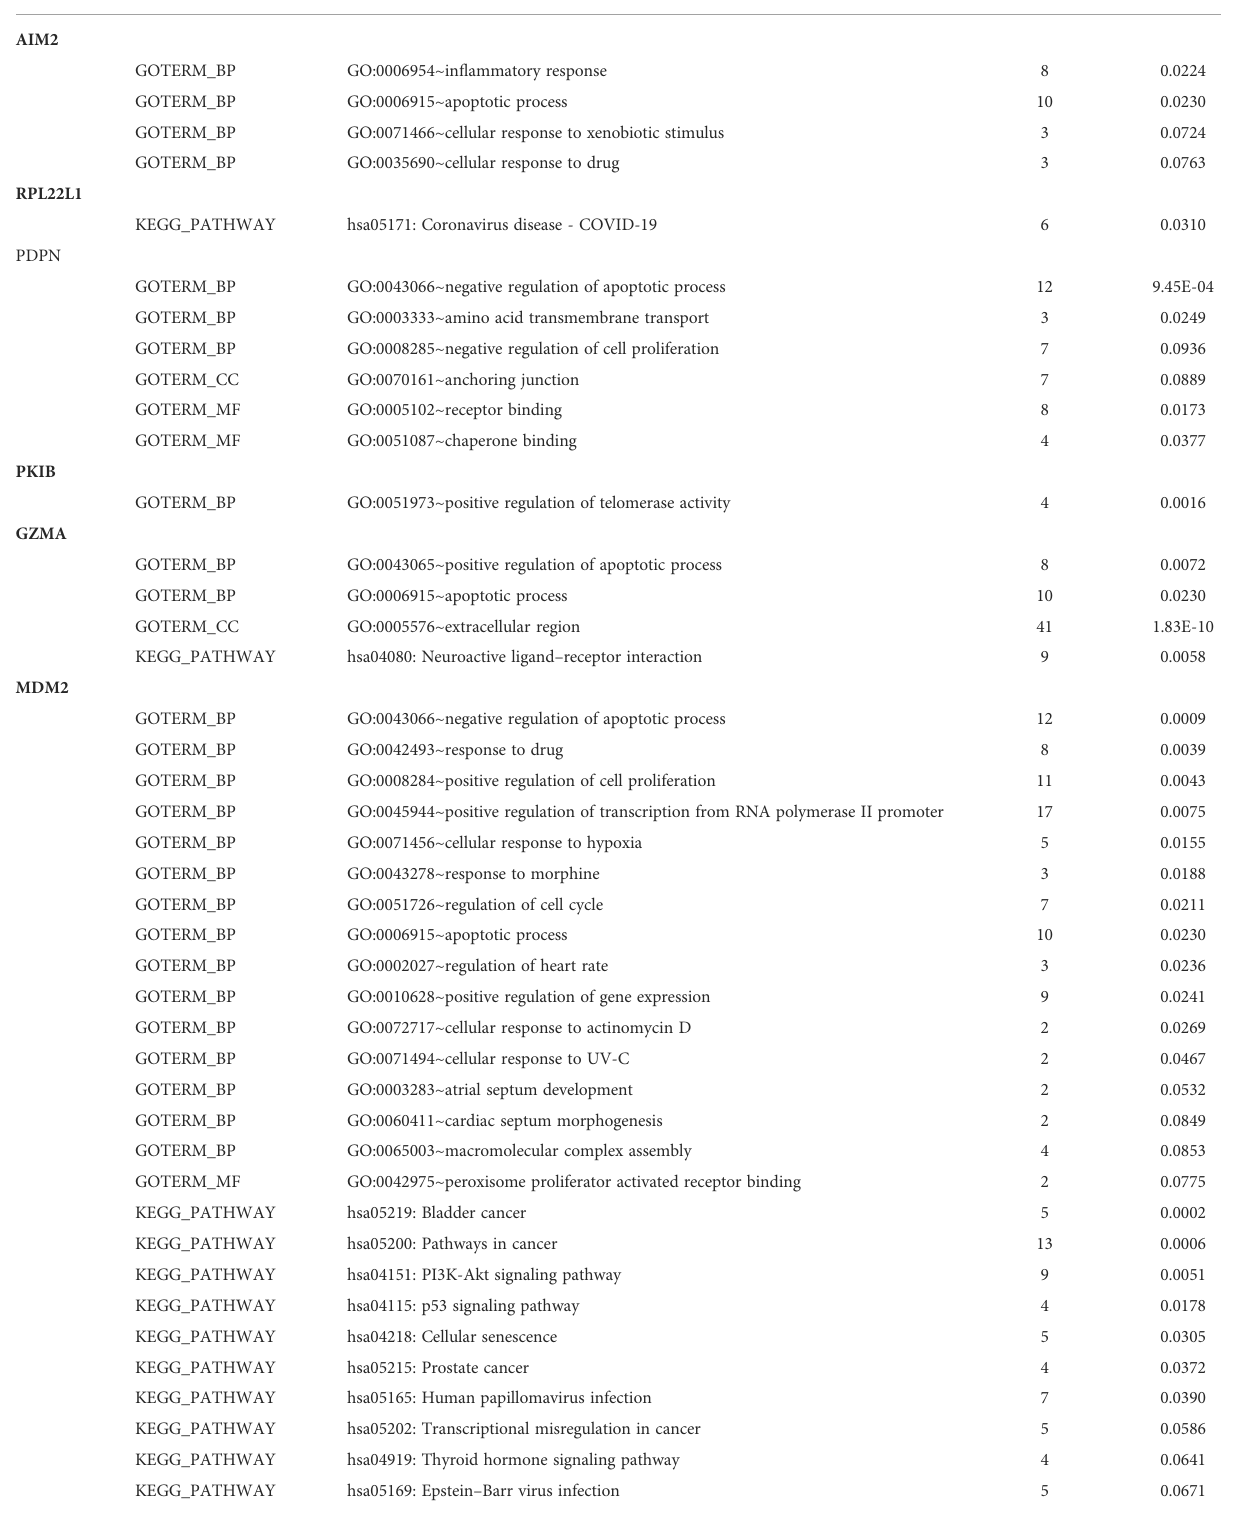
TABLE 2 The ontology and KEGG pathway that the hub genes are involved in.